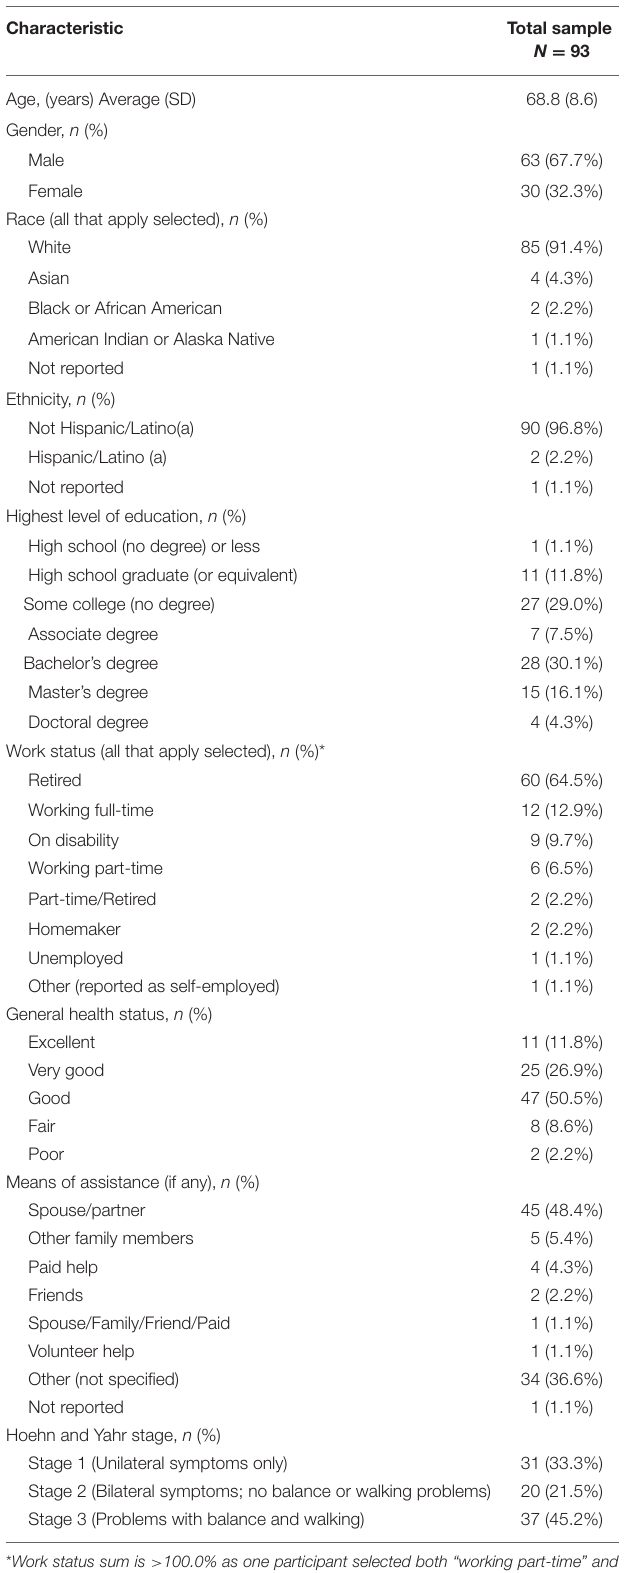
TABLE 3 | Participant-reported demographic and health information.